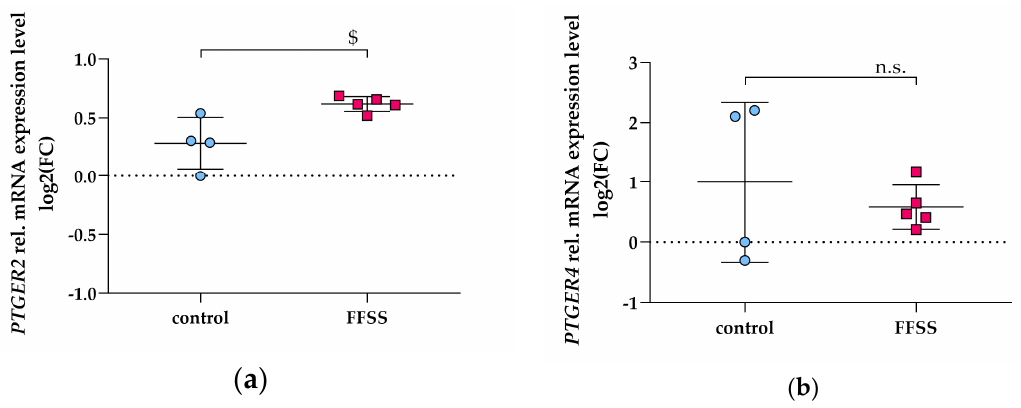
Figure 8. PTGER2 and PTGER4 gene expression in hPC subjected to FFSS (pink squares). qPCR results are presented as relative mRNA expression level normalized to GAPDH and referred to control group (blue circles). mRNA expression of PTGER2 ( a ) and PTGER4 ( b ) was quantified after 2 h of FFSS with 2 dynes / cm 2 . Statistics: $, p < 0.05, assessed by a two-tailed Student’s t -test. Each datapoint represents a single sample and plotted as mean ± SD (horizontal lines) per treatment group consisting of n = 4–5 replicates obtained in a single experiment.